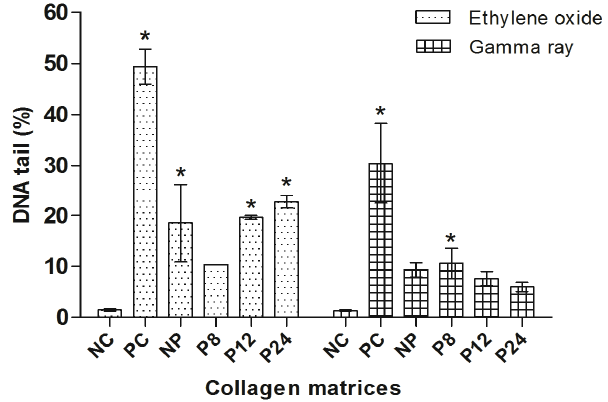
Figure 4. Comet assay in CHO-K1. NC: negative control; PC: positive control. Columns = mean of percentage of DNA in tail; bars = standard error. * = p < 0.01 compared to NC, Dunnett’s test.